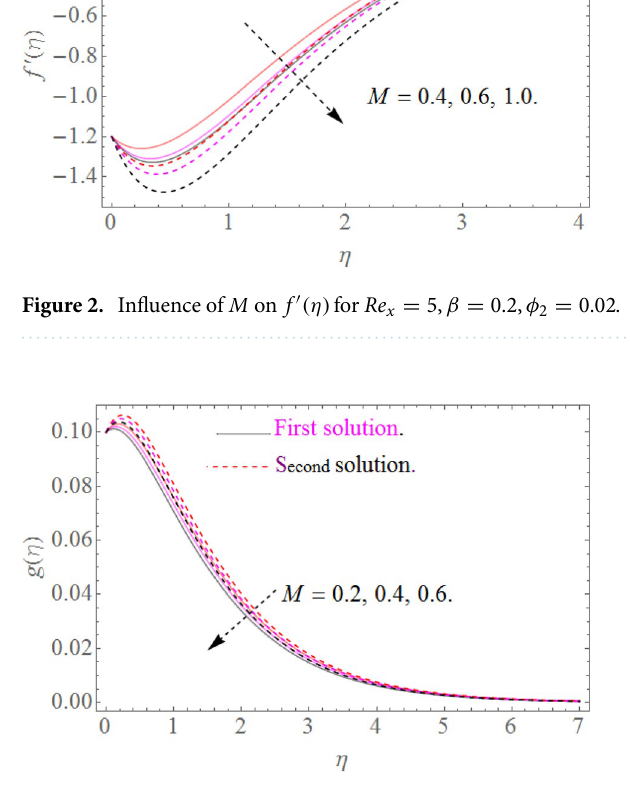
Figure 3. Influence of M on g (η) for Re x = 5, β = 0.2, φ 2 = 0.02 .